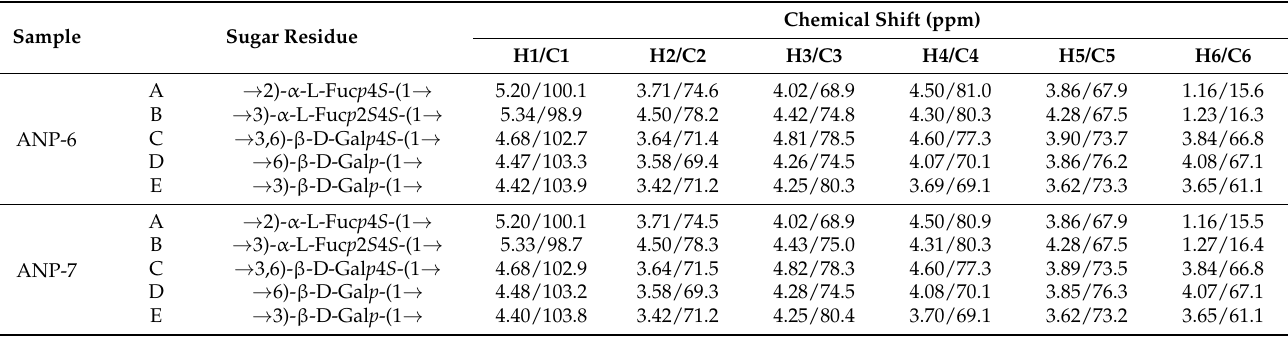
Figure 3. COSY spectra of ANP-6 ( A ) and ANP-7 ( B ) and HSQC spectra of ANP-6 ( C ) and ANP-7 ( D ). Table 3. Chemical shift assignments of ANP-6 and